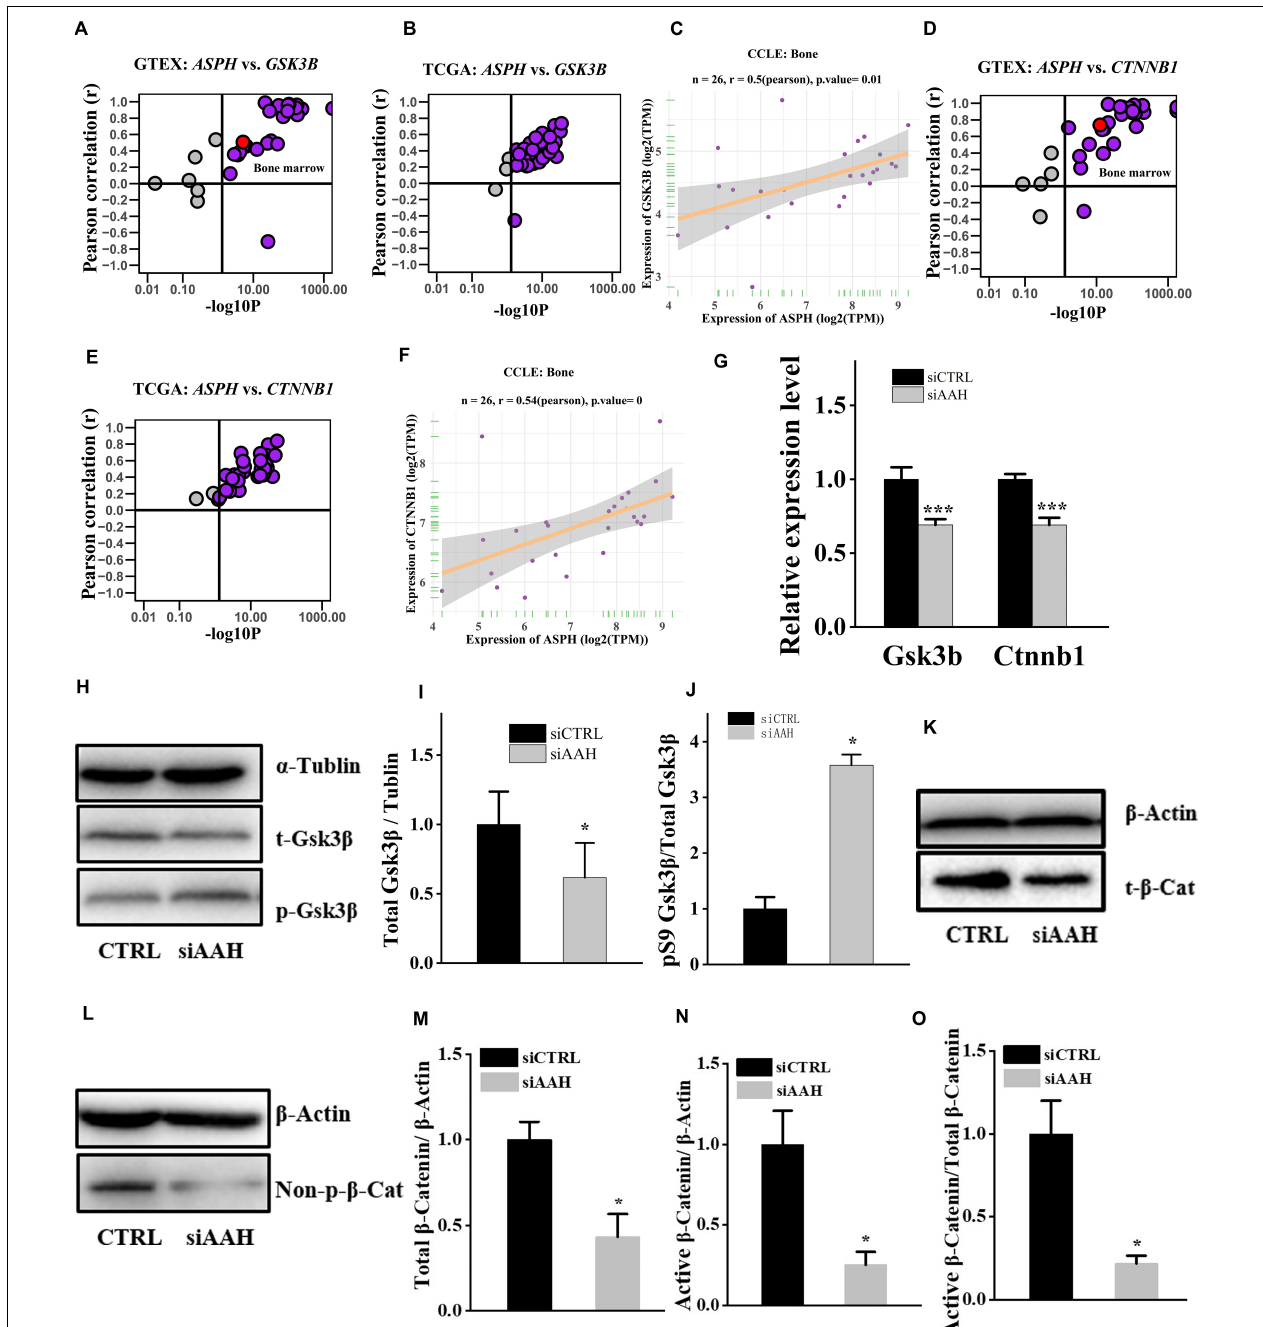
FIGURE 5 | ASPH regulates Gsk3 β and β -Catenin. (A–C) Co-expression of ASPH with GSK3B in expression in normal tissues (A) , cancer samples (B) , and bone-related cell lines (C) , based on the data from GTEx, TCGA, and CCLE databases, respectively. (D–F) Co-expression of ASPH with CTNNB1 in expression in normal tissues (D) , cancer samples (E) , and bone-related cell lines (F) , based on the data from GTEx, TCGA, and CCLE databases, respectively. The correlation coefficient (r) and P -value were calculated by Pearson’s Correlation analysis. Note that every dot represents one tissue type (A,D) or one cancer type (B,E) . The red dots indicate tissue of bone marrow. (G) qRT-PCR analysis of GSK3B and CTNNB1 in BMSCs interfered with Asph siRNA in vitro . (H) Western Blot analysis of the levels of total GSK3 β and phos-Ser9 GSK3 β in BMSCs transfected with Asph siRNA. (I) The ratio of total Gsk3 β to α -Tublin in BMSCs transfected with Asph siRNA. (J) The ratio of phos-Ser9 GSK3 β (pS9 GSK3 β ) to total GSK3 β in BMSCs transfected with Asph siRNA. (K) Western Blot analysis of the levels of total β -Catenin (t- β -Cat) in BMSCs transfected with Asph siRNA. (L) Western Blot analysis of the levels of active β -Catenin [Non-phospho β -Catenin (Ser33/37/Thr41): Non-p- β -Cat] in BMSCs transfected with Asph siRNA. (M) The ratio of total β -Catenin to β -Actin in BMSCs transfected with Asph siRNA. (N) The ratio of active β -Catenin to β -Actin in BMSCs transfected with Asph siRNA. (O) The ratio of active β -Catenin to total β -Catenin in BMSCs transfected with Asph siRNA. These experiments were replicated 3 times. Error bars show standard deviation. * P < 0.05, *** P < 0.001.